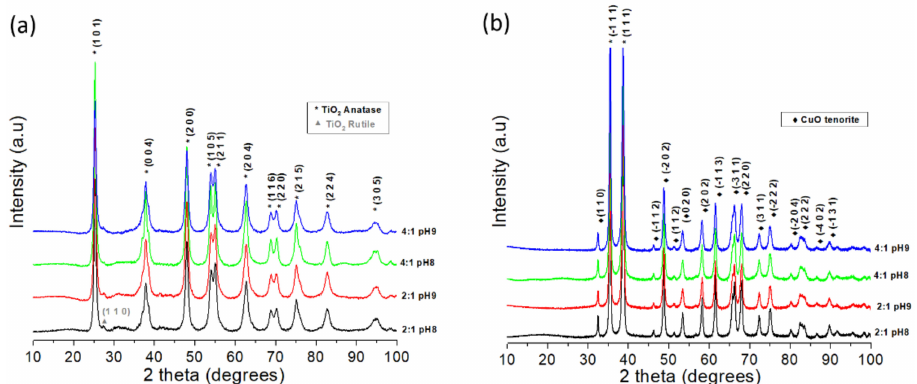
Figure 1. X-ray diffractograms for the ( a ) TiO 2 and ( b ) CuO powders synthesized using the four Pechini method